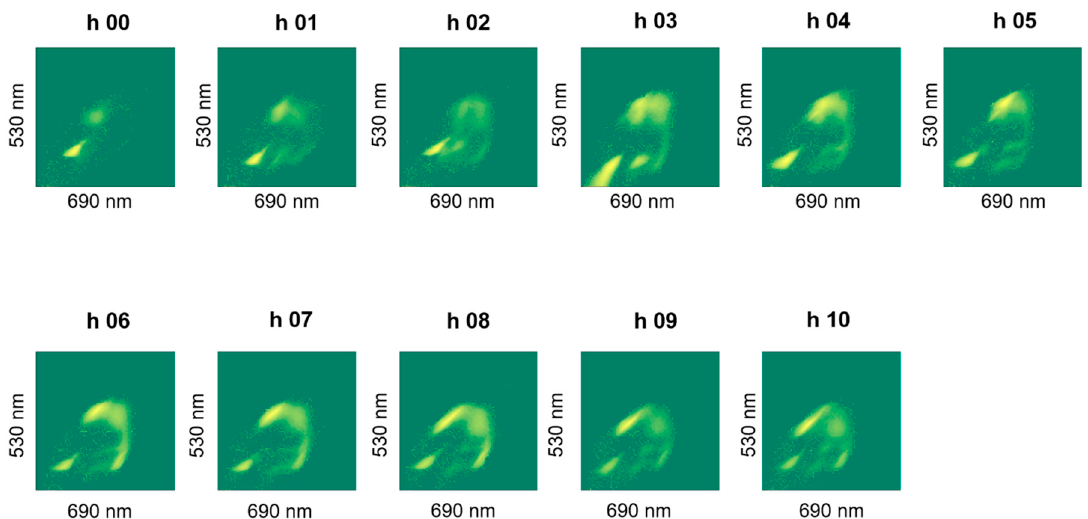
Figure A2. Plot of FL 1 against FL 2 fluorescence intensities of hourly samples showing dynamics of clusters observed during fermentation for pH-A (3) batch.